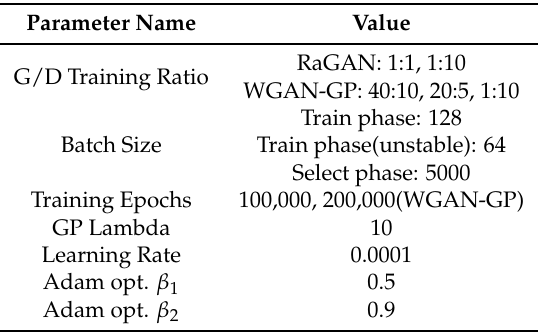
Table 2. REDPACK